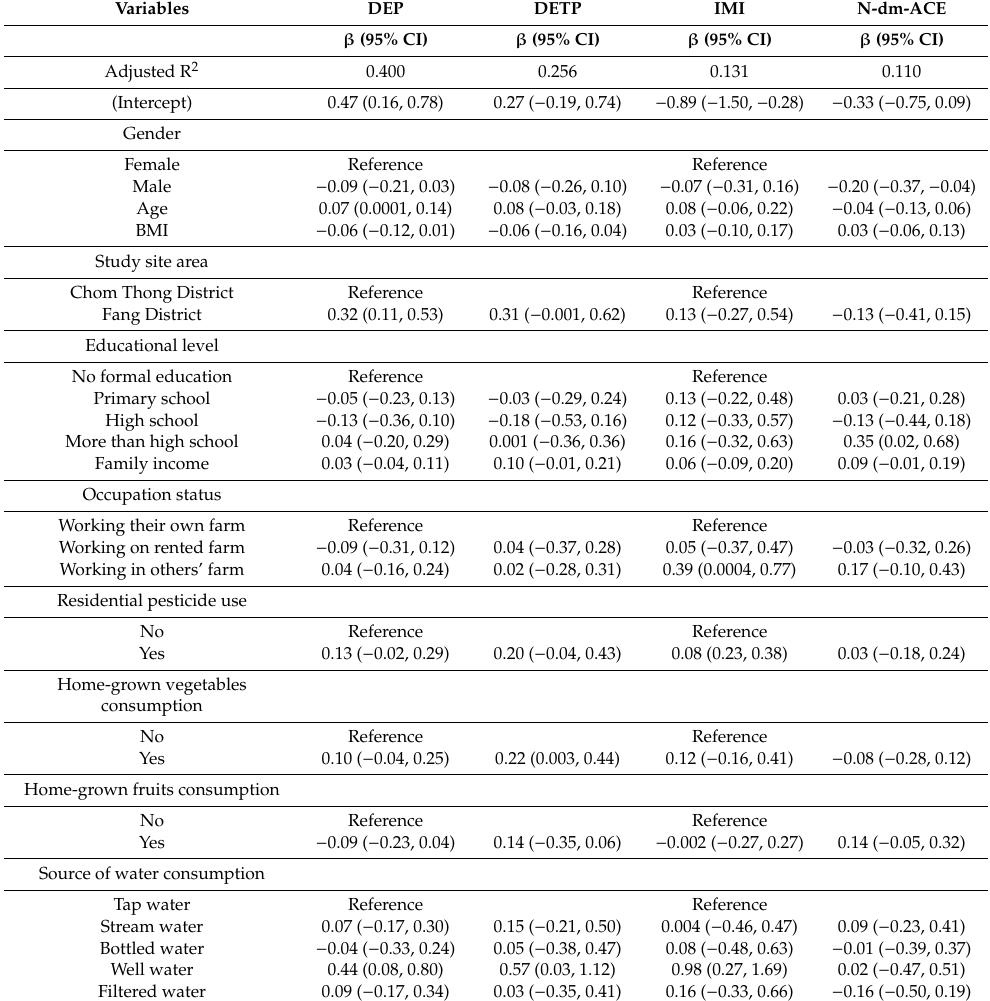
Table 2. Predictors of urinary concentrations of DAP in reproductive-age farmworkers (N = 100). Variables DEP DETP